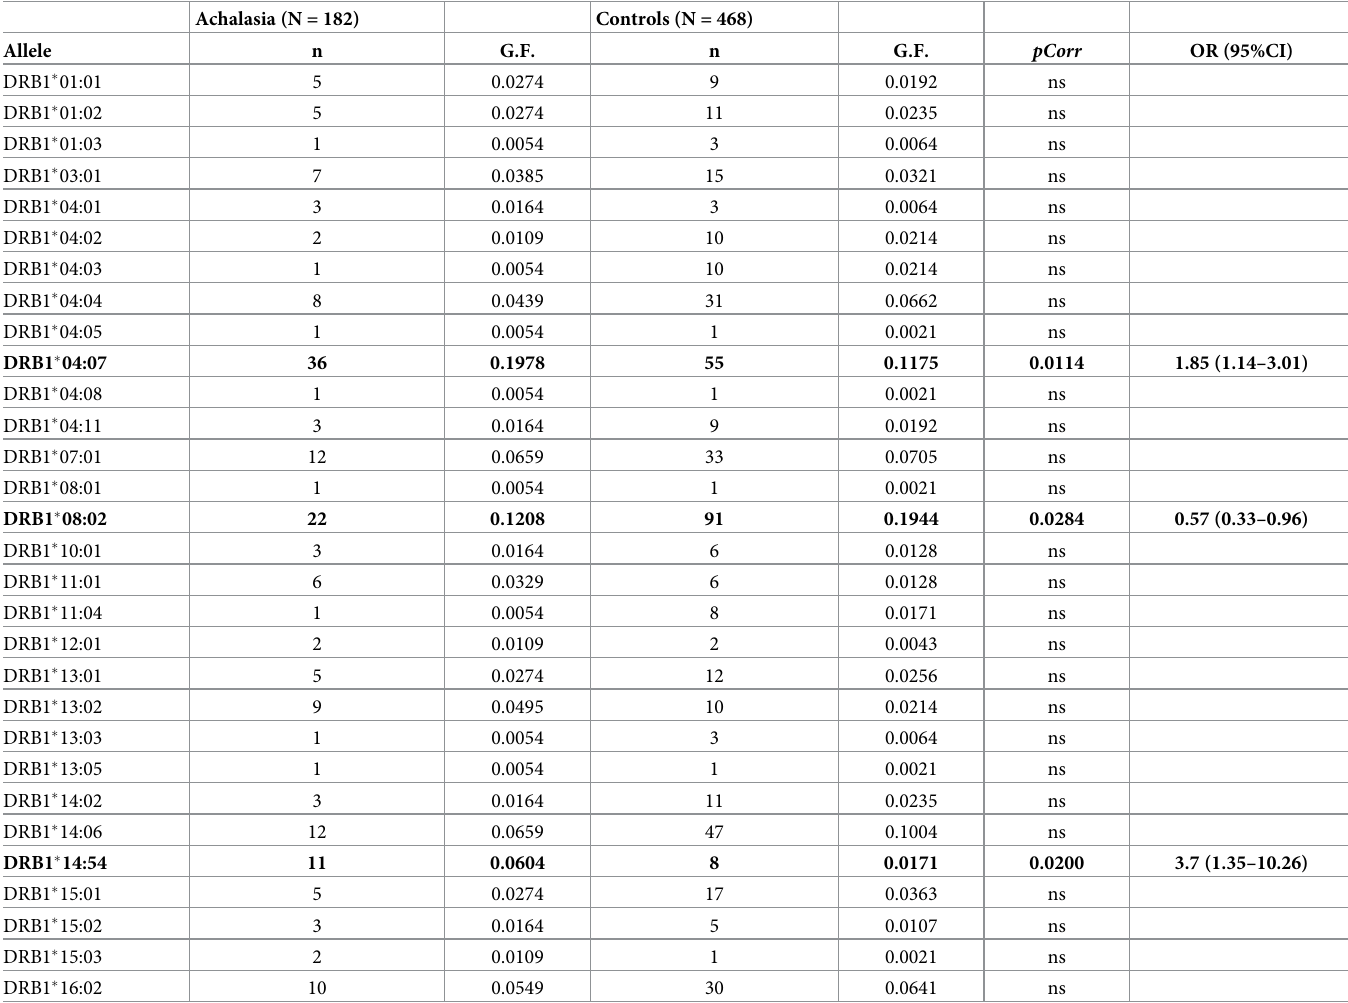
Table 3. Gene frequencies of HLA-DRB1 in achalasia patients and healthy